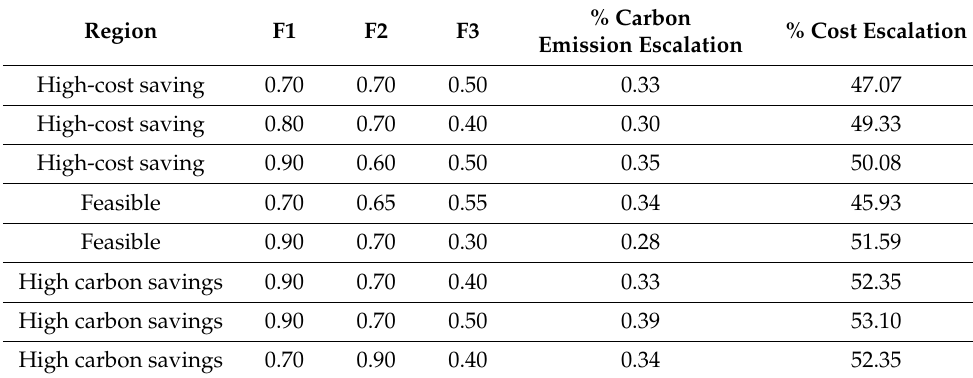
Table 6. Fibre contents (in kg) in the optimal mix designs (per m 3